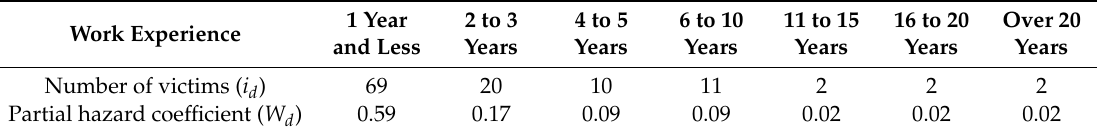
Table 7. Victim’s work experience.